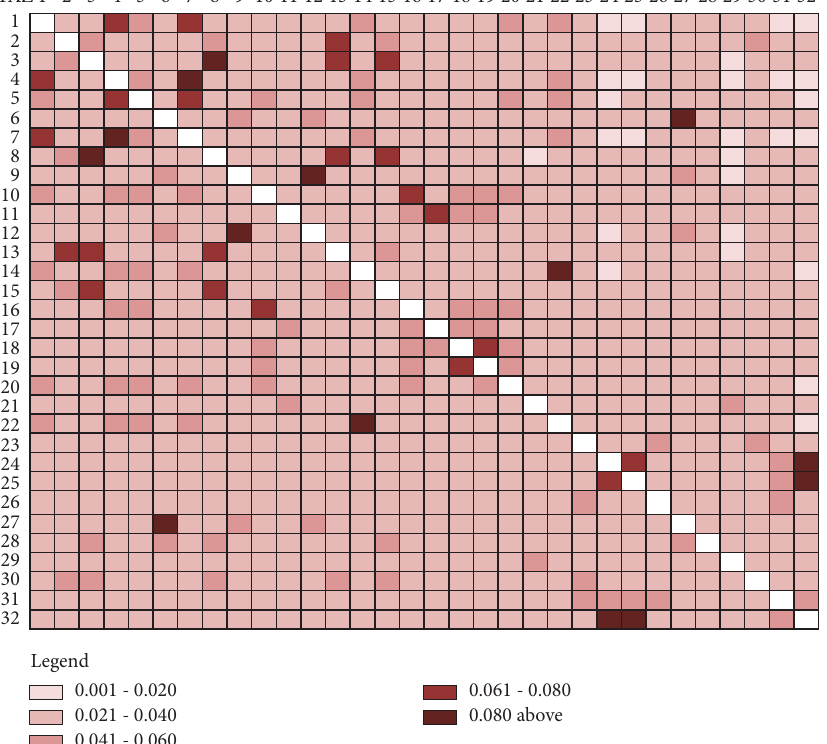
Figure 11: Weight element categorization in weekday.